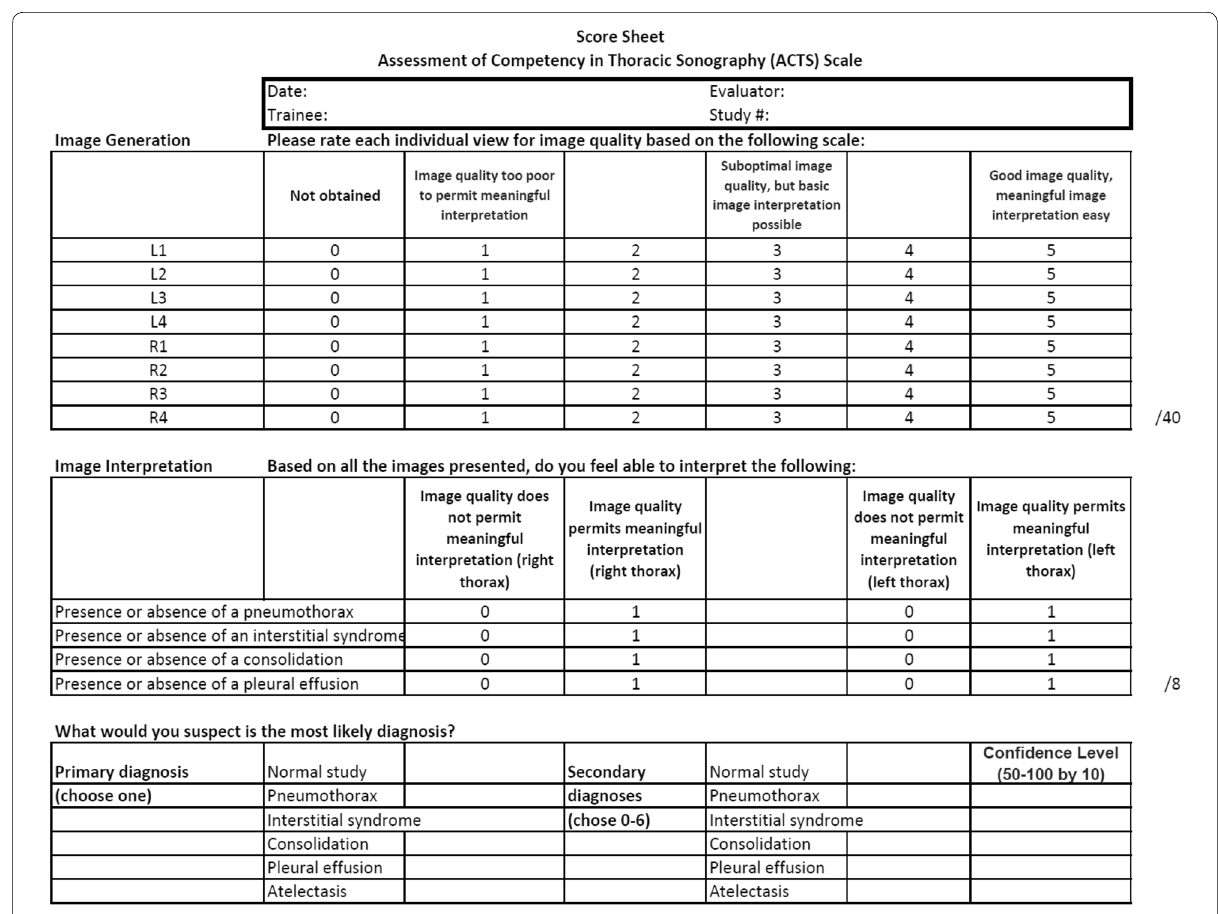
Fig. 1 The Assessment of Competency in Thoracic Sonography (ACTS)